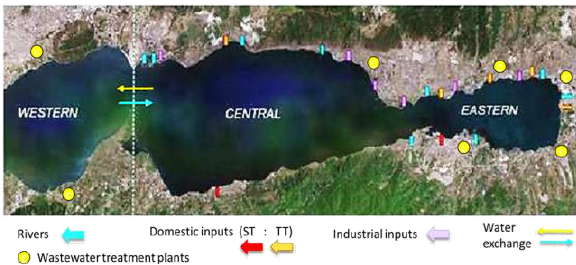
Figure 2. Locations of main freshwater input source points and wastewater treatment plants in the eastern, central and western basins of the Gulf of Izmit (adapted from Ergül, 2016; Tolun et al., 2012 ).